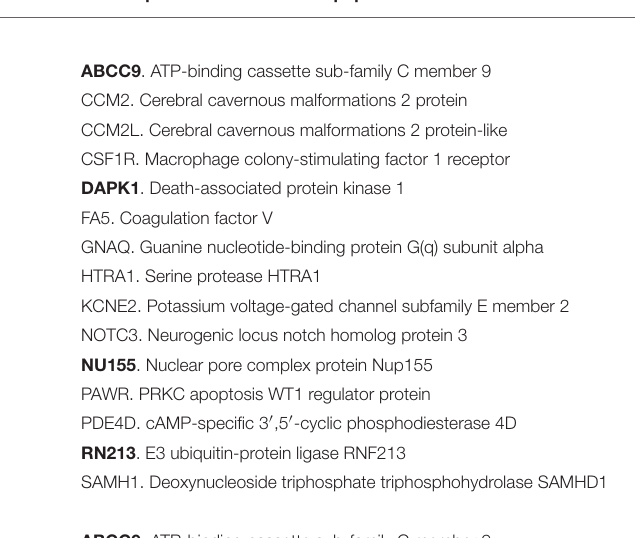
TABLE 1 | Peptide sharing between pathogen antigens and human proteins that have been associated with stroke 1 . Shared peptides